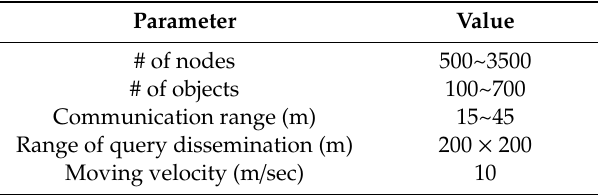
Table 5. Performance evaluation environments.